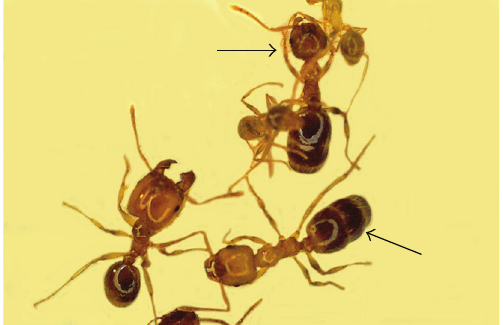
Figure 7: Two mermithid-infected soldiers (mermithostratiotes) (arrows) of Pheidole pallidula adjacent to smaller workers and an uninfected soldier (with large head). Note smaller heads on infected soldiers. Photo courtesy of Luc Passera.